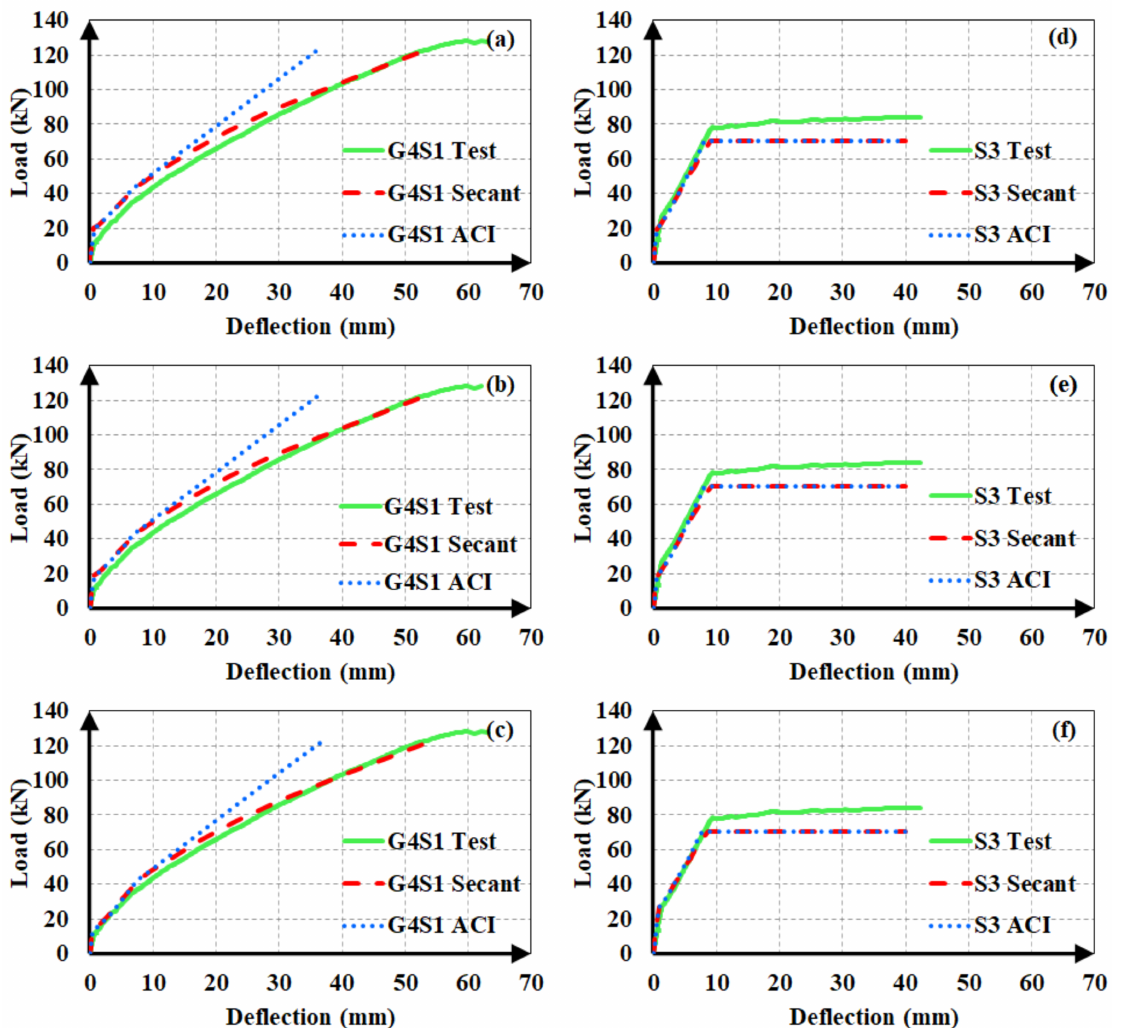
Figure 15. Load-deflection curves based on the analytical cracking moments from ( a , d ) the uncracked transformed cross- section; ( b , e ) gross cross-section; and ( c , f ) experimental cracking